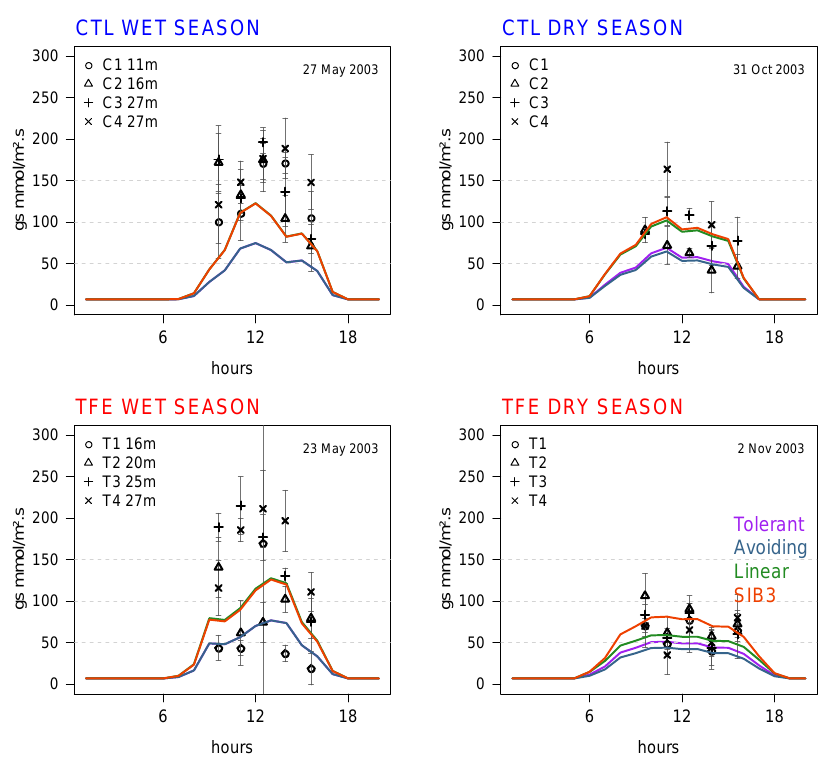
Figure 6. Seasonal variability of the diurnal cycle of stomatal conductance at Caxiuanã. Measurements were taken on 4 days at four different Figure 6 – Seasonal variability of the diurnal cycle of stomatal conductance at Caxiua˜na. Measurements were taken on heights in the canopy: C1–C4 designate trees in the control (CTL) plot and T1–T4 trees in the throughfall exclusion (TFE) plots and simulated 4 days at 4 different heigths in the canopy : C1-C4 designate trees in the CTL plot and T1-T4 trees the TFE plots and g s with the four water stress functions (WSFs) (lines) are representing all simulated g s with the 4 WSF (lines) are representing the all canopy